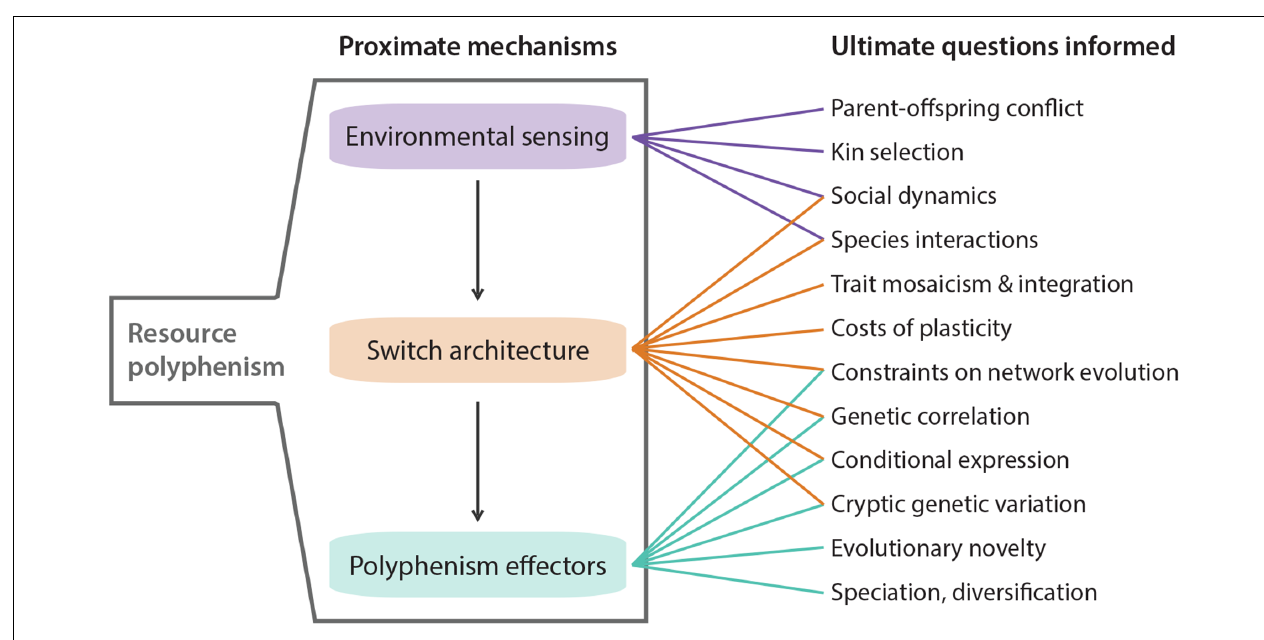
species kill other isolates at higher rates than their own (Lightfoot et al., 2019). Kin discrimination in this system largely depends on the identity of a hypervariable small peptide that is expressed